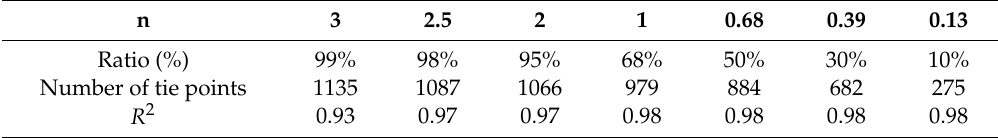
Table 2. An example of ratio, number, and R 2 of tie points by n for the standard